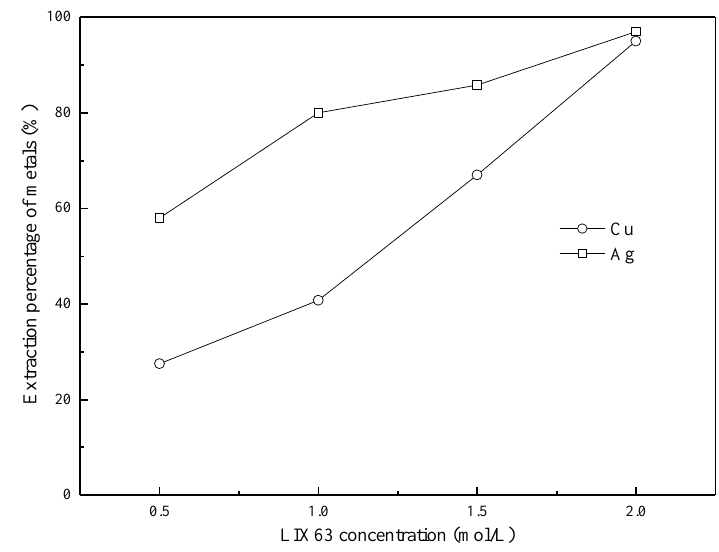
Figure 2. Effect of the LIX63 concentration on the extraction of metals.